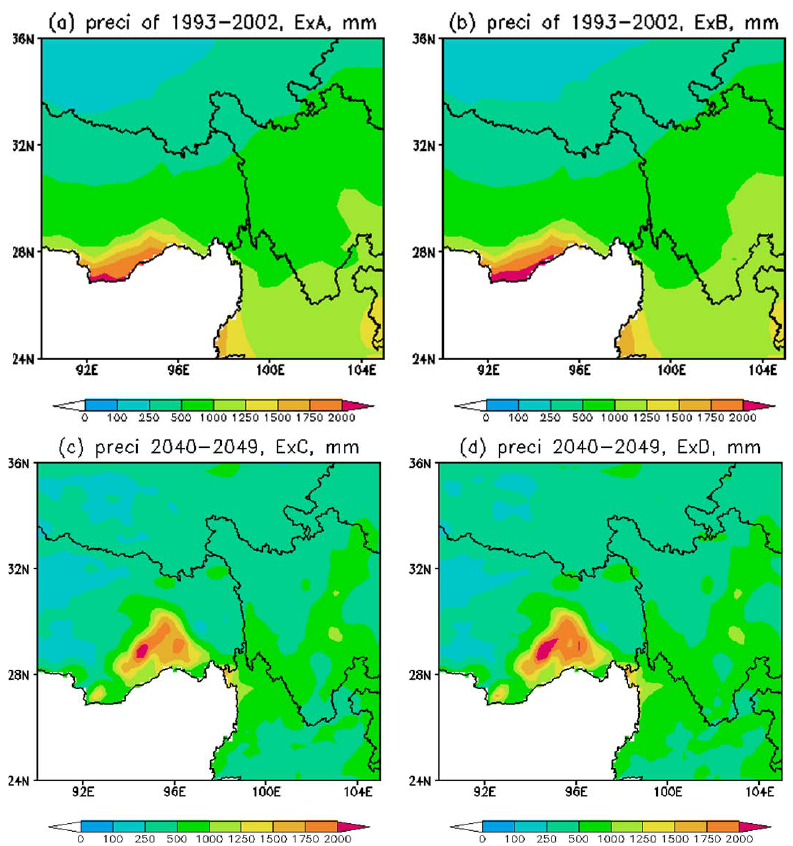
Fig. 4. The spatial distribution of average annual precipitation under the four scenarios. (a) 1993–2002 without reservoirs; (b) 1993–2002 with reservoirs; (c) 2040–2049 without reservoirs; (d) 2040–2049 with